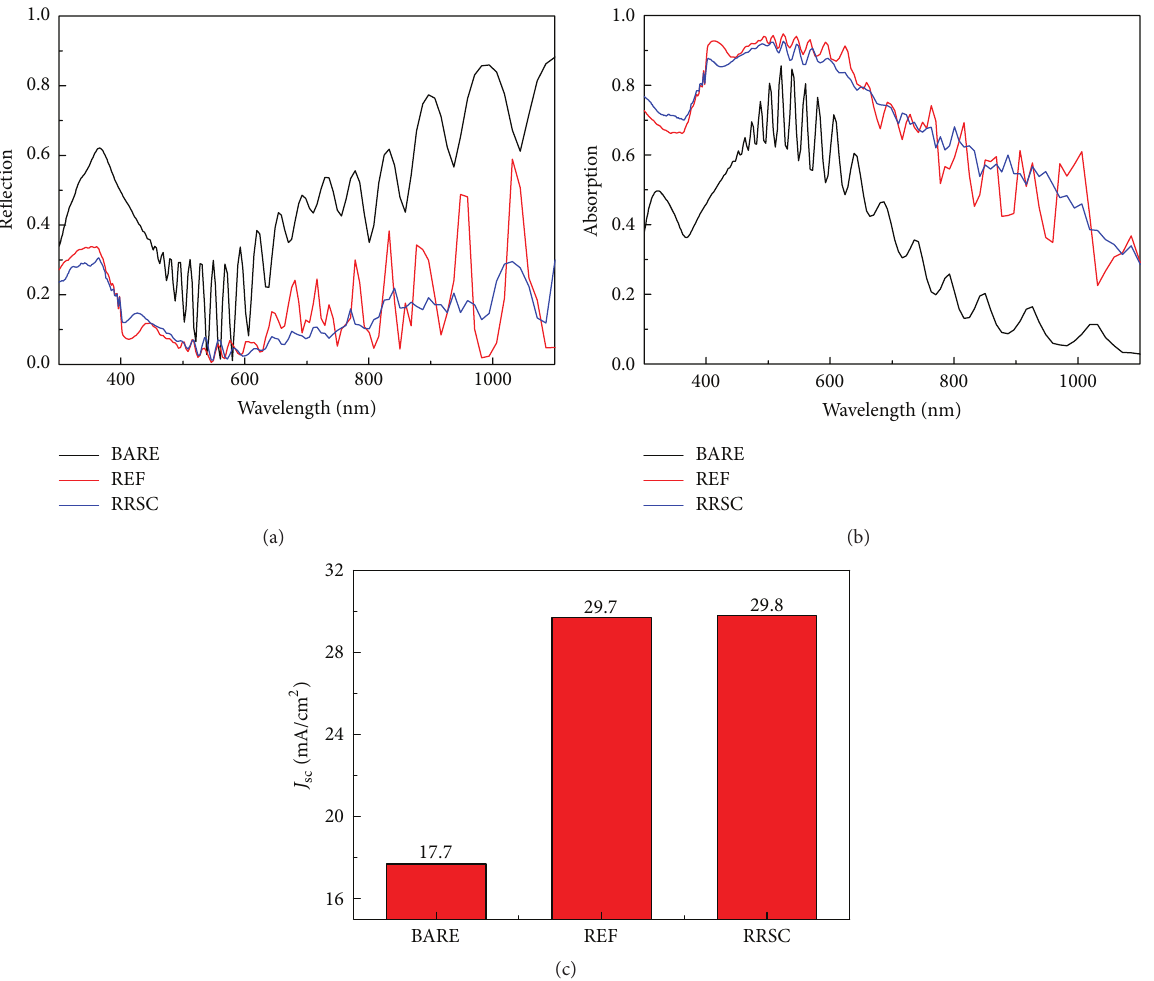
Figure 3: The reflection (a), the absorption (b), and the short circuit current density (c) of the BARE cell, the REF cell, and the RRSC with random radius of the grating